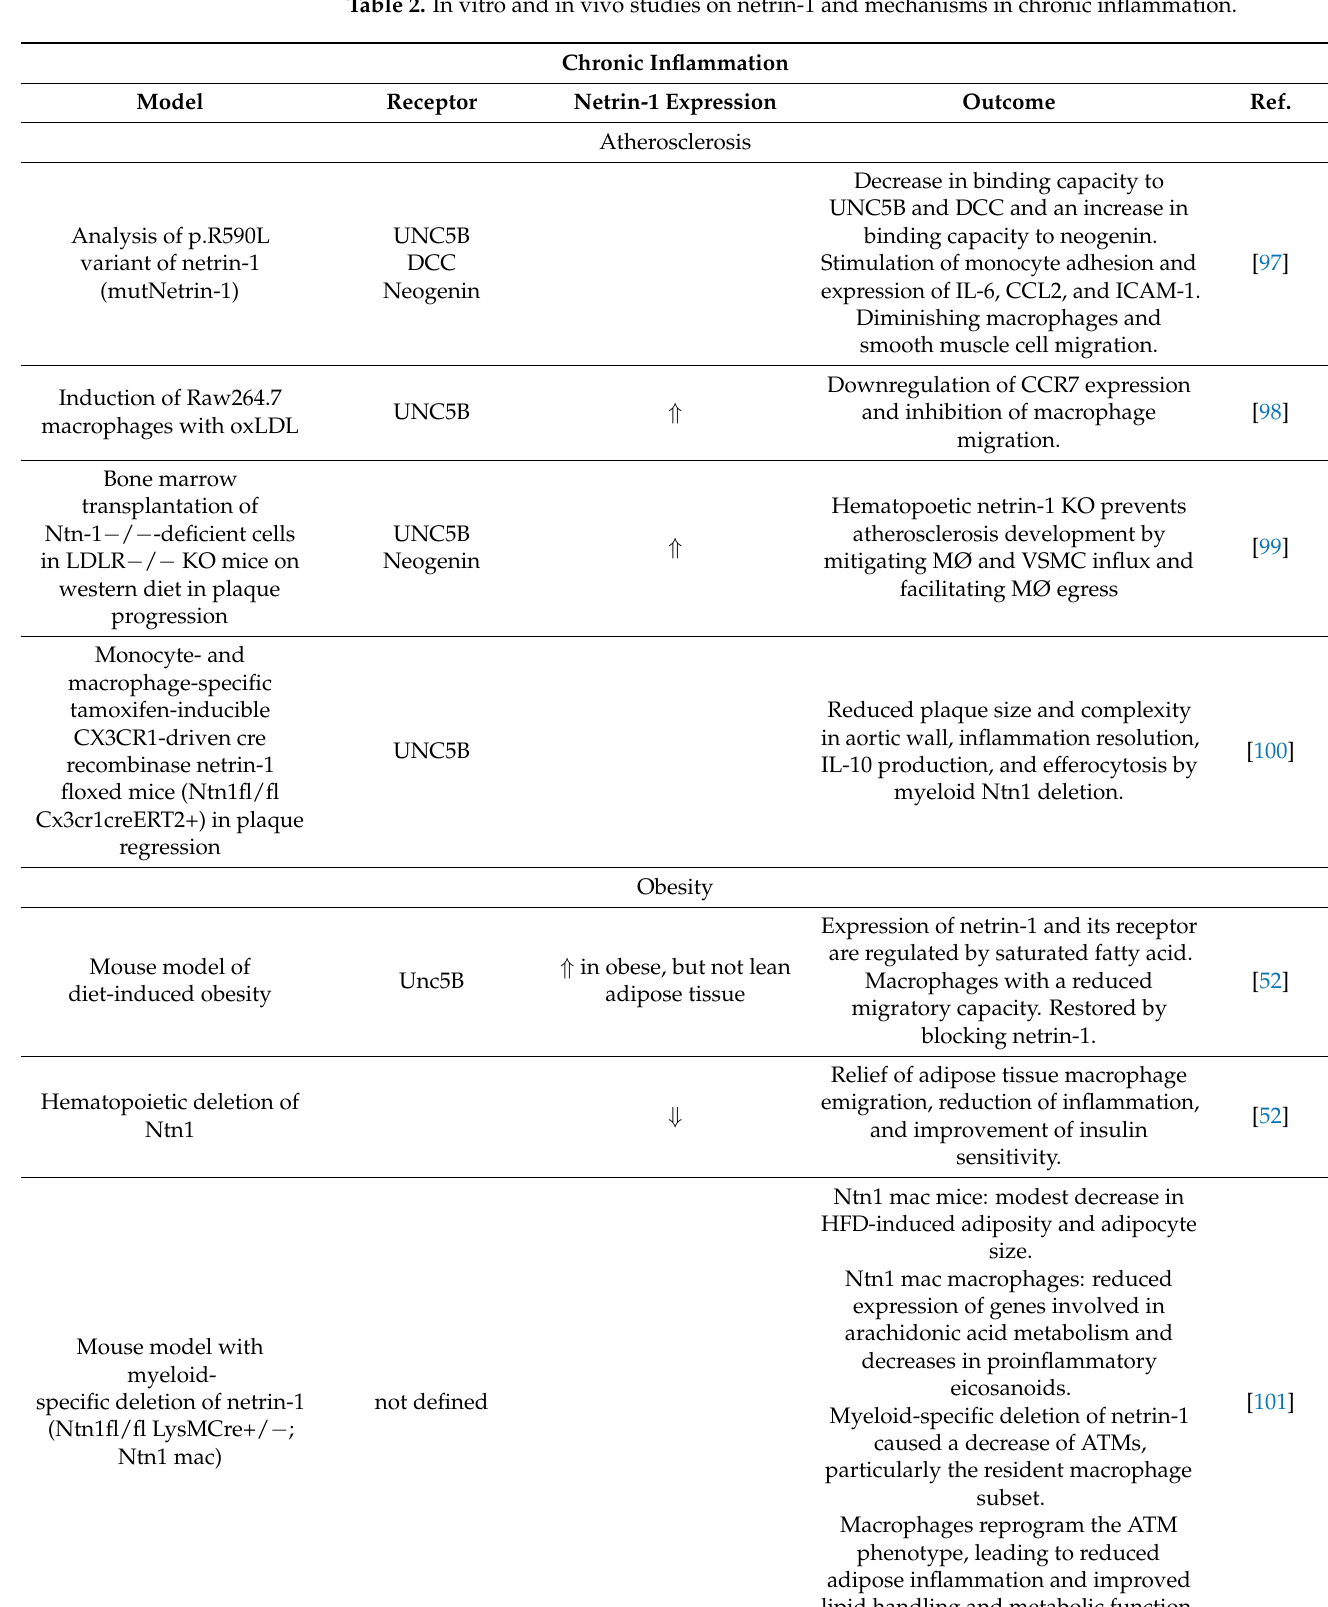
Table 2. In vitro and in vivo studies on netrin-1 and mechanisms in chronic